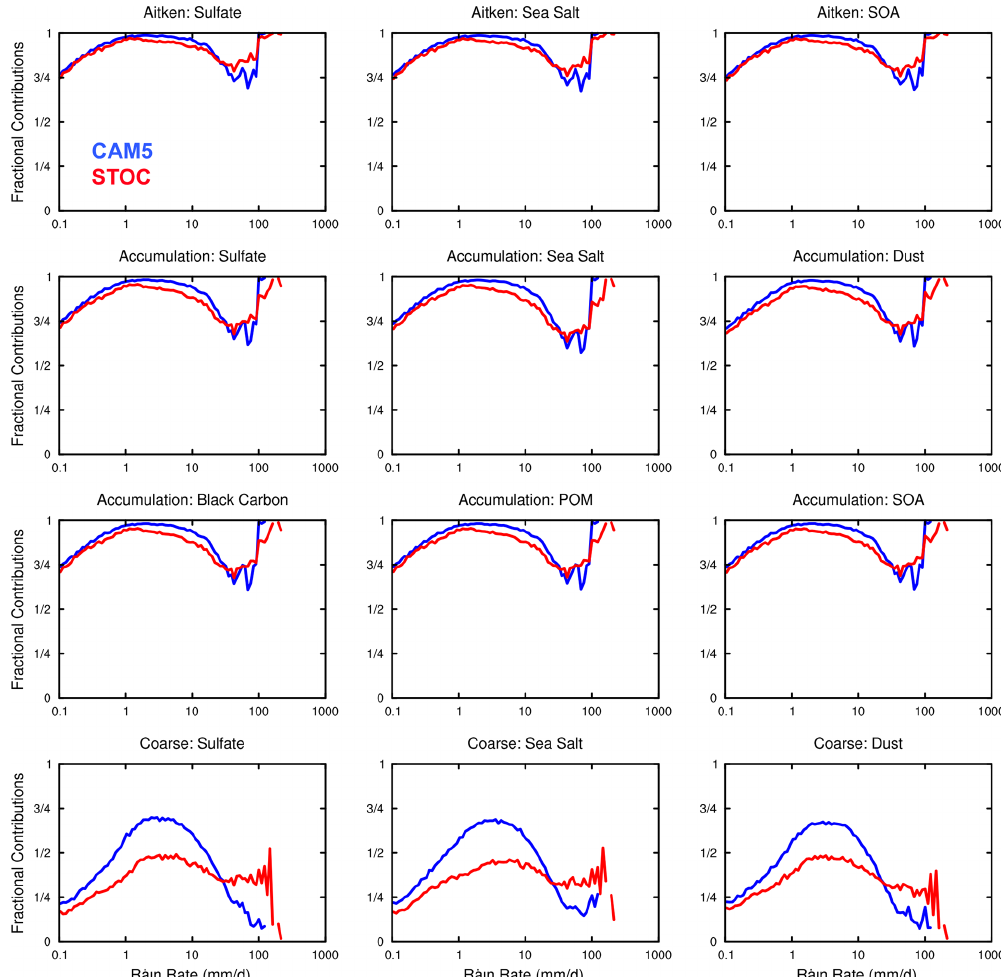
Figure 9. Same as Fig. 8, but over 20, 50 ◦ N.